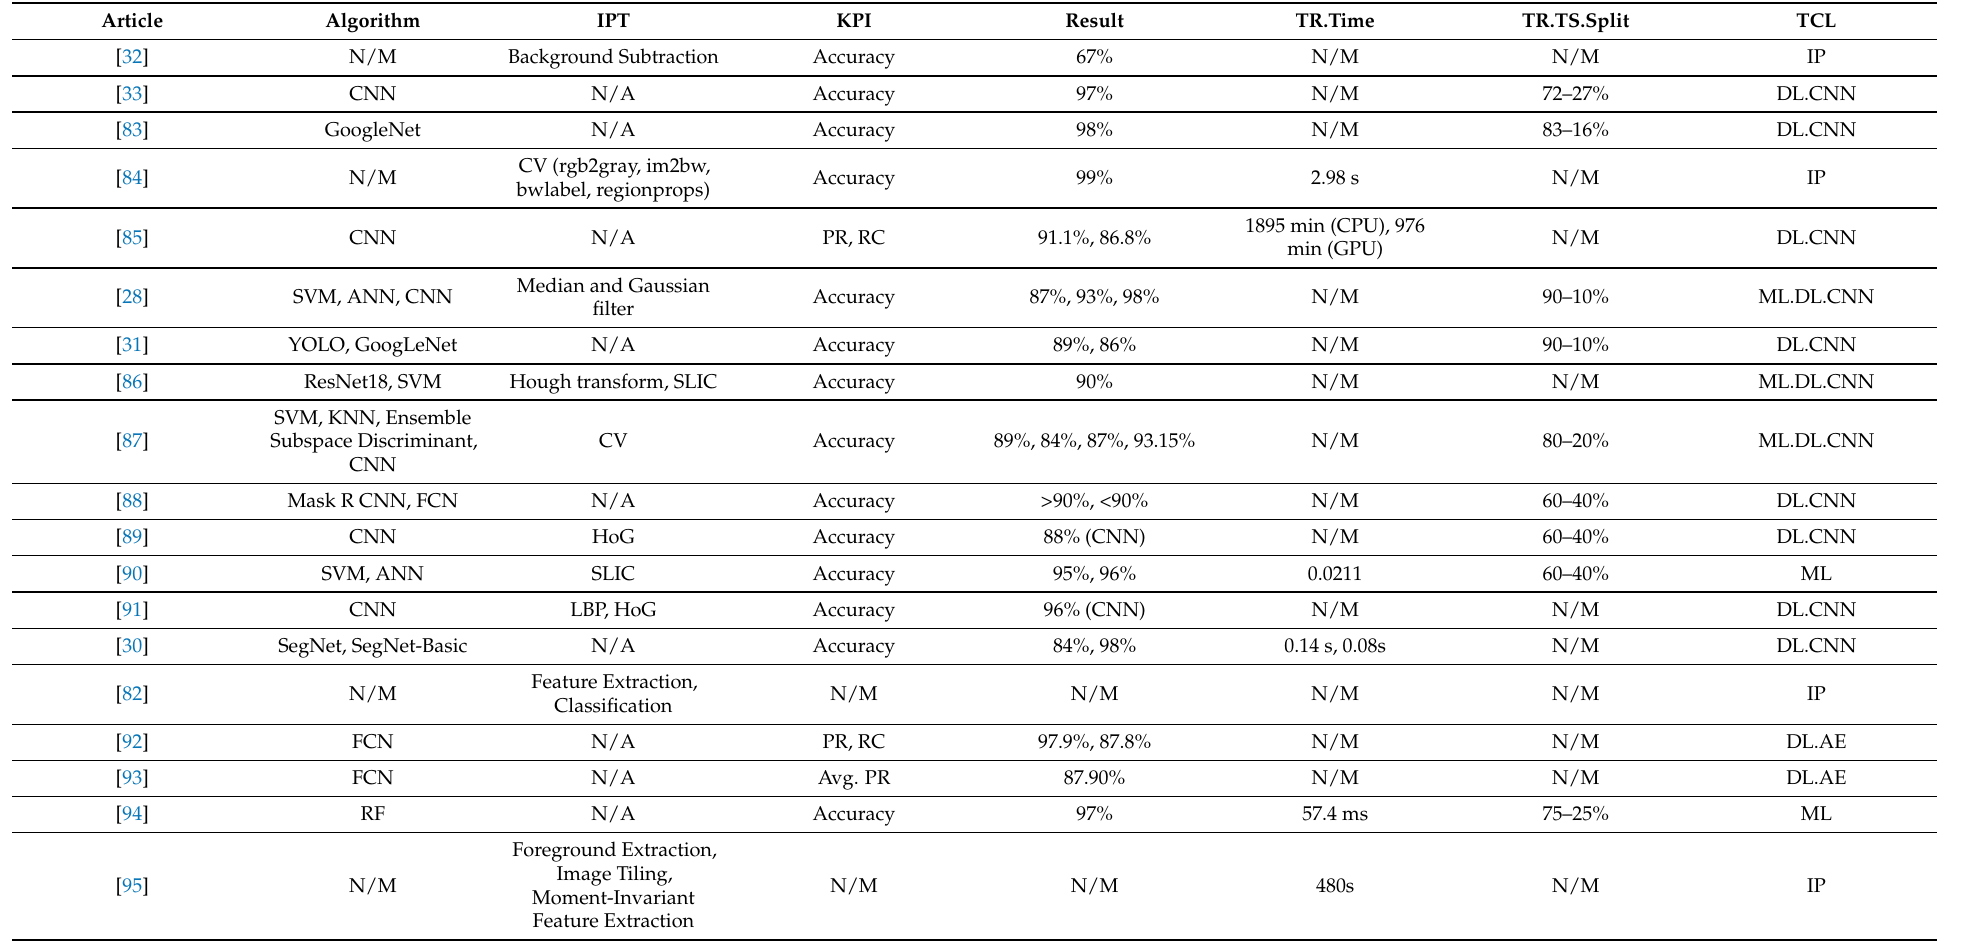
Table 3. Algorithmic Performance and Related Data for our application